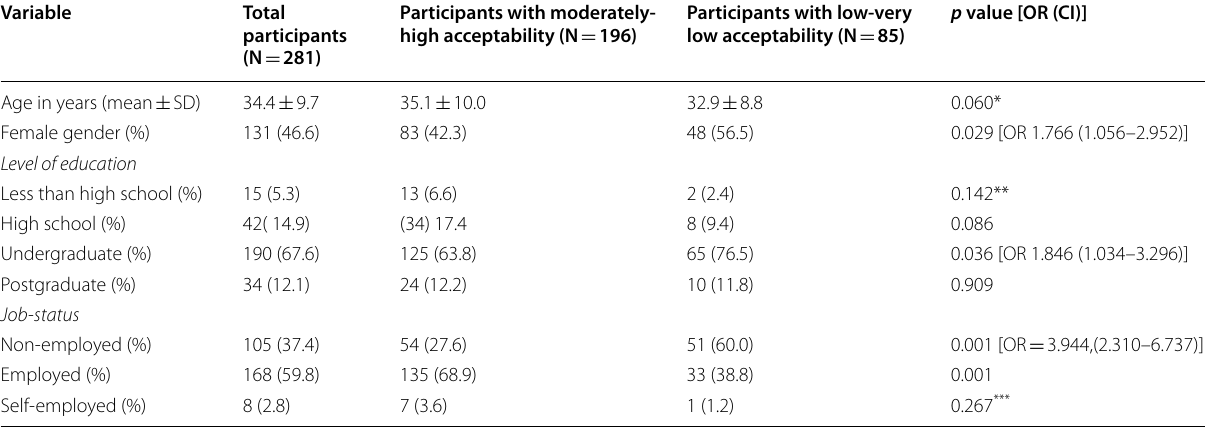
Table 1 The acceptance rate among studied participants relative to their background variables